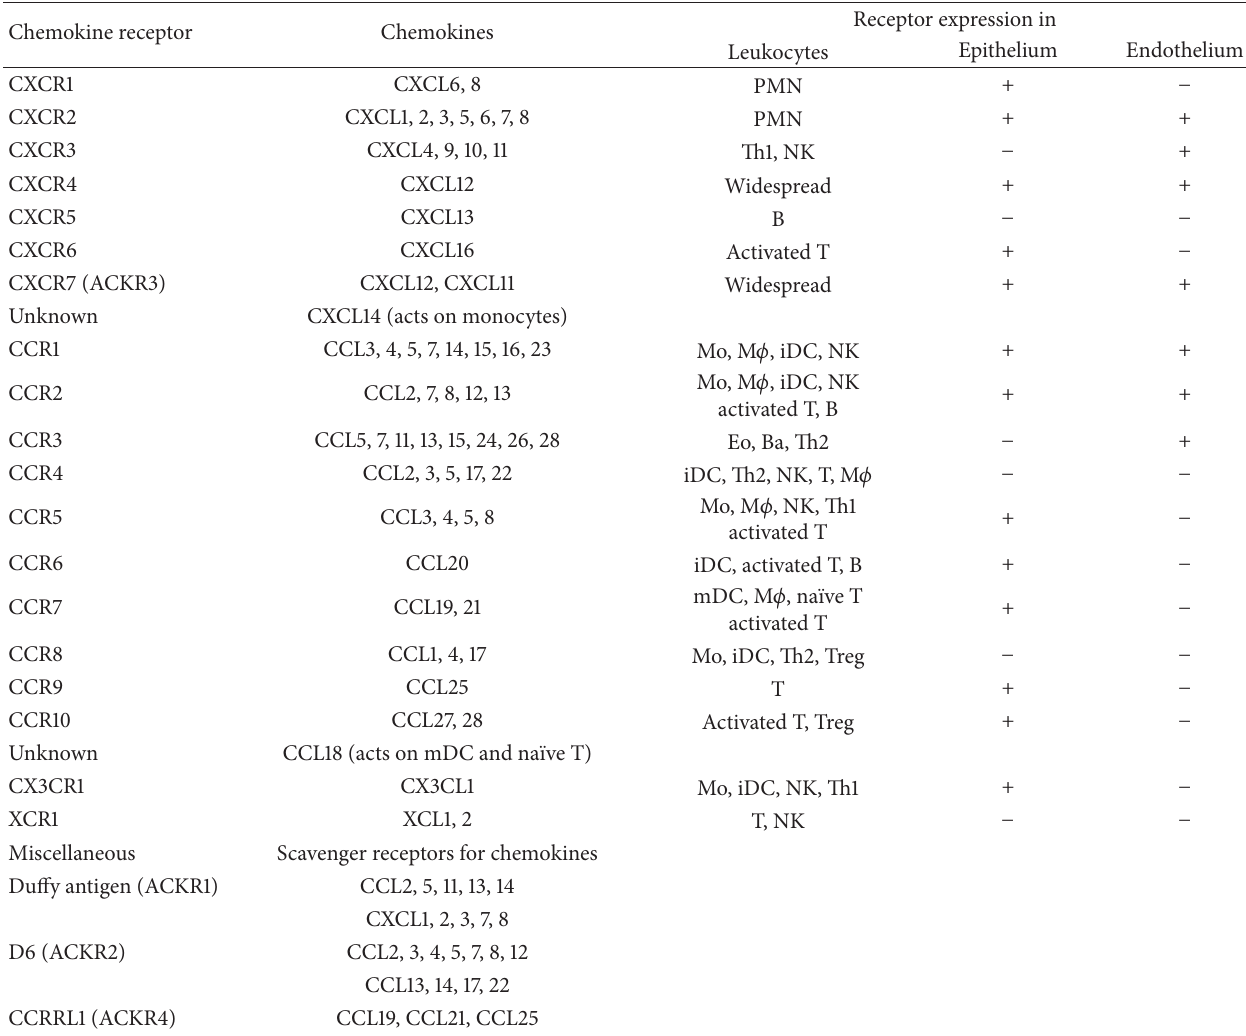
Table 1: The human chemokine